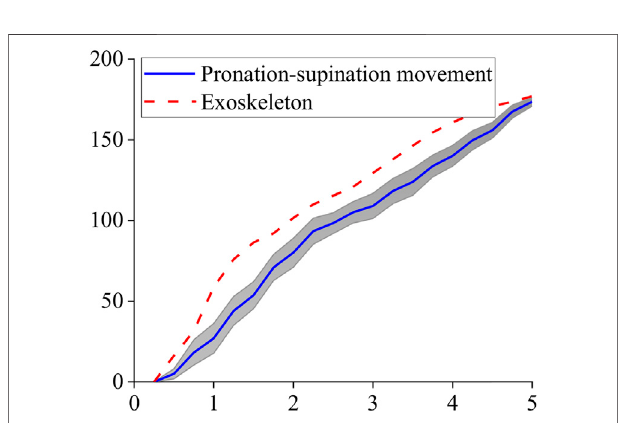
FIGURE 8 | Tracking result of pronation – supination movement DOF. FIGURE 9 | Subject 1 tracking results of pronation – supination